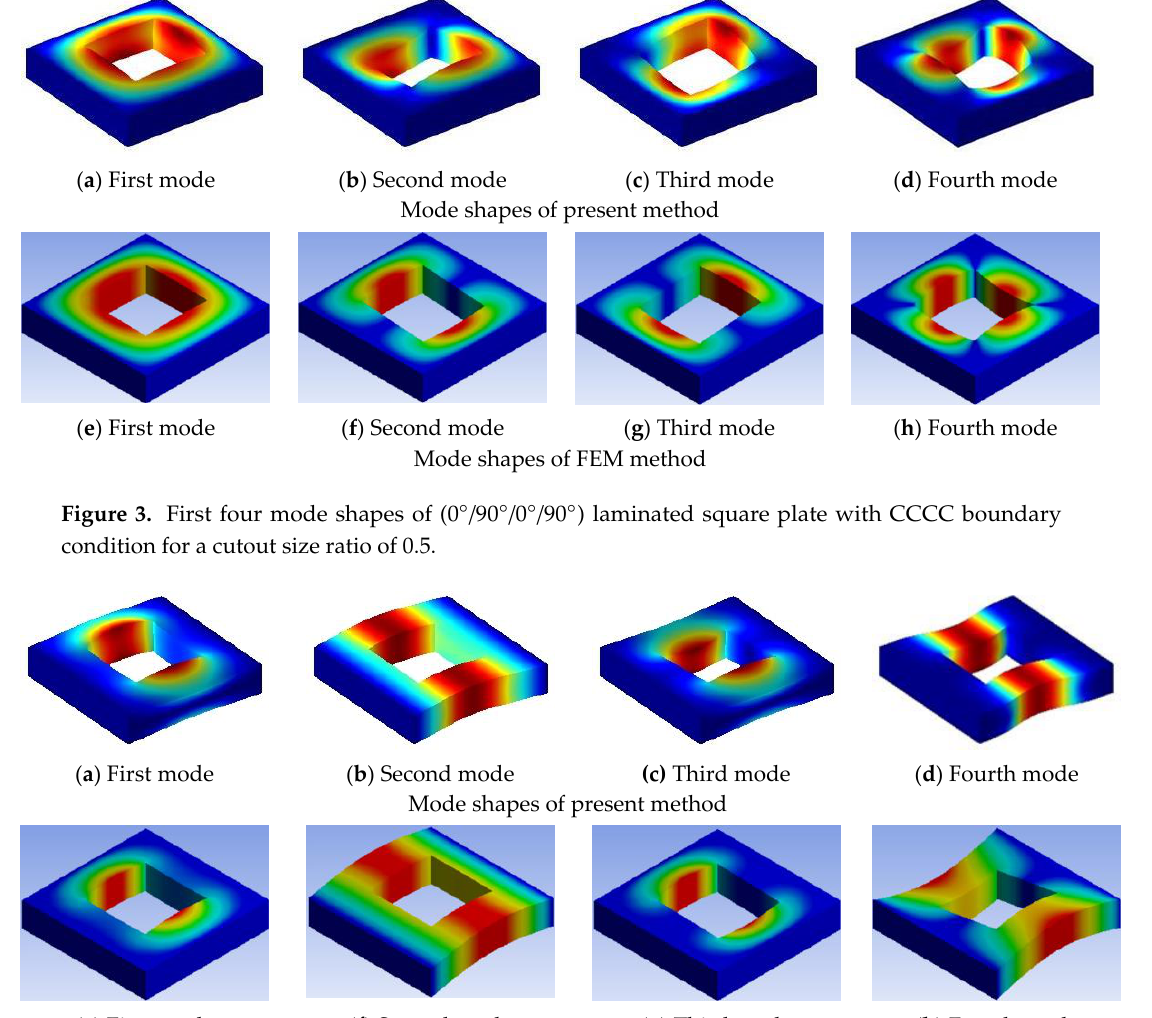
Figure 3. First four mode shapes of (0°/90°/0°/90°) laminated square plate with CCCC boundary condition for a cutout size ratio of 0.5. Table 8. Some of the first 20 frequency parameters Ω of cross-ply (0°/90°/90°/0°) laminated square plate with different cutout sizes under CSCS boundary condition